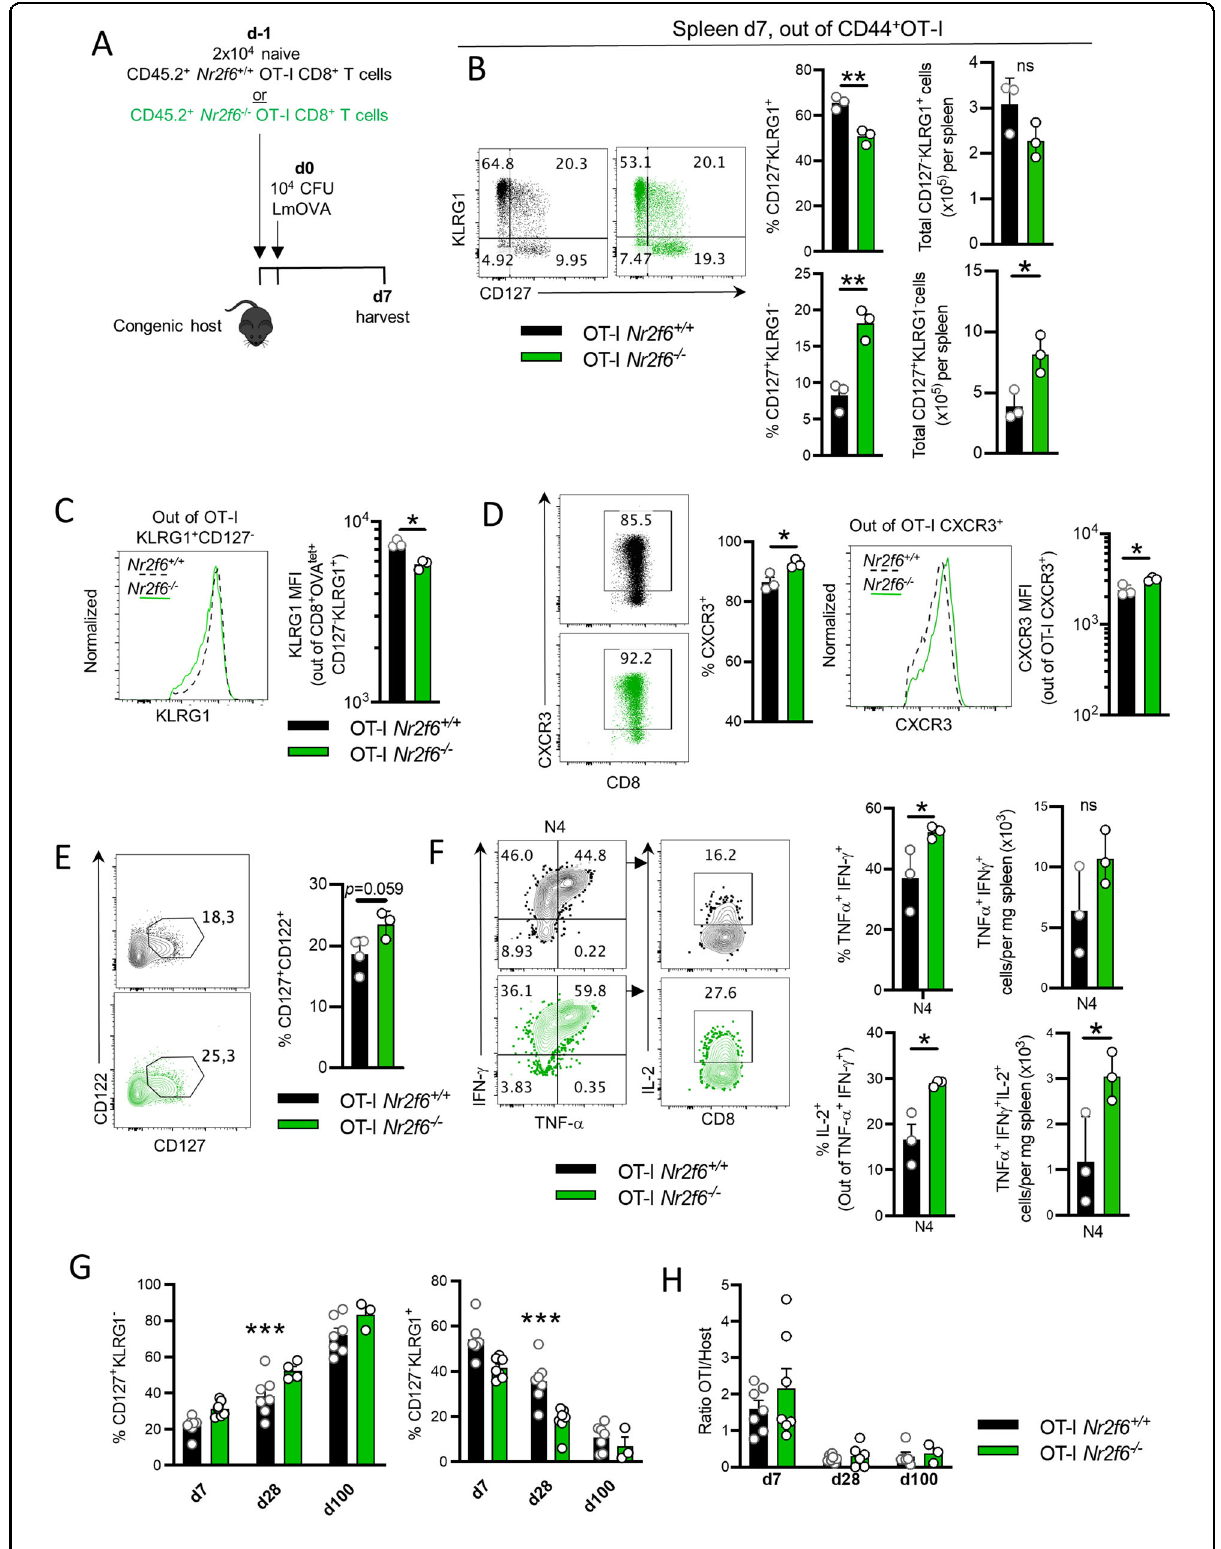
Fig. 2 (See legend on next